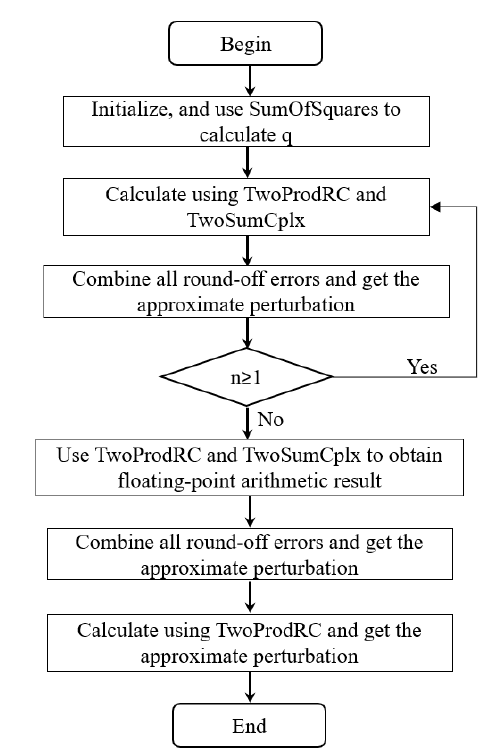
Figure 1. The flowchart of the compensated Goertzel